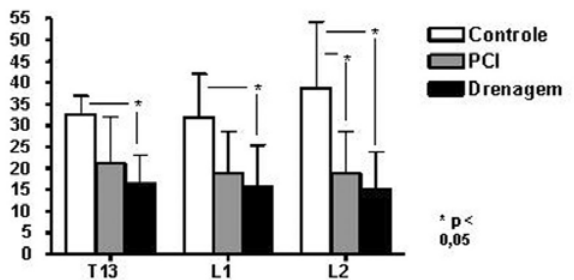
Fig. 7 - Número de neurônios necróticos, nos três grupo,s nos níveis T13, L1 e L2. Os valores estão apresentados em média e desvio-padrão